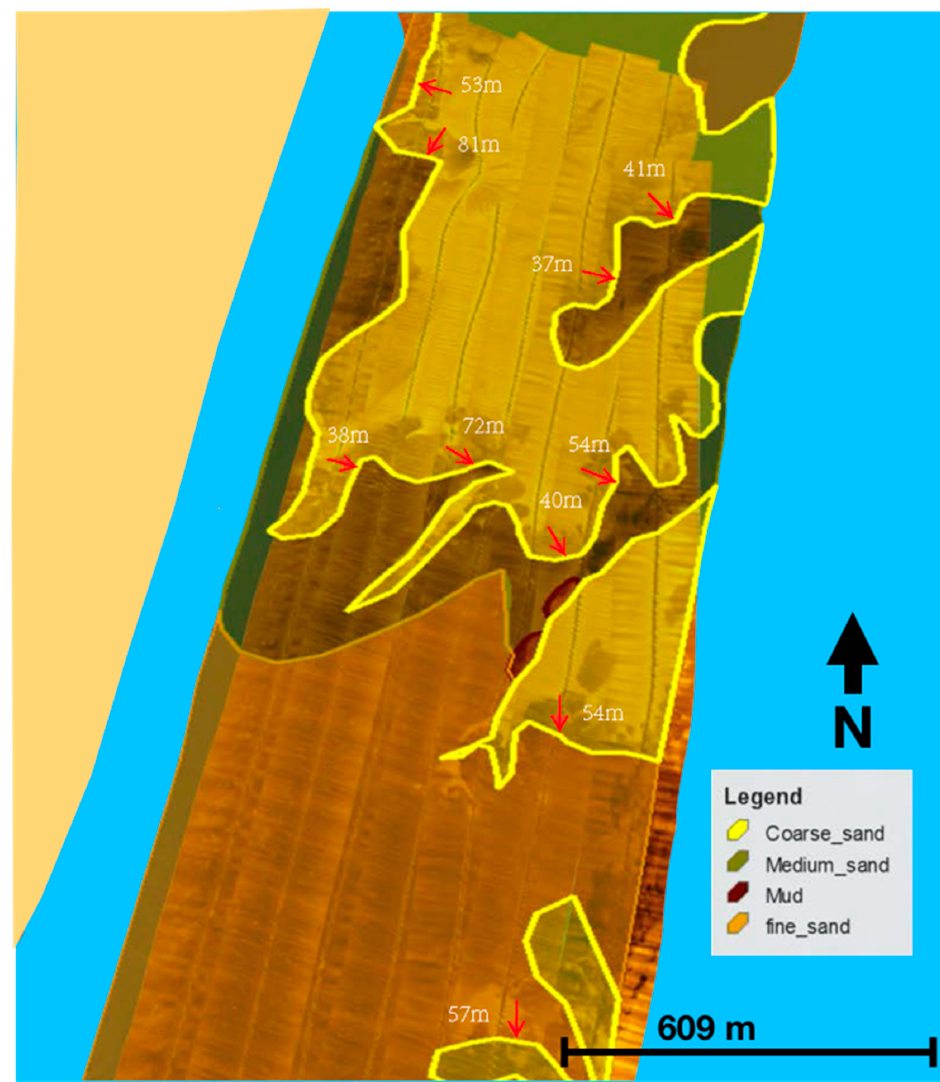
Figure 19. Temporal changes in sediment class boundaries, Assateague Island National Seashore, Maryland. The profile in the bottom is the side-scan sonar mosaics collected during May 2015. Shaded polygons on the top represent sediment classes inferred from the side-scan sonar mosaics collected during October 2015. Please note the west-south-eastward shift (38–57 m) in the boundaries of fine–coarse sand sediment classes.